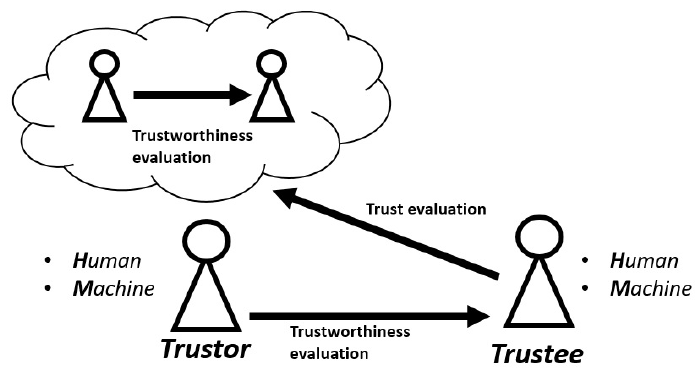
Figure 1. Relationship between trustworthiness and